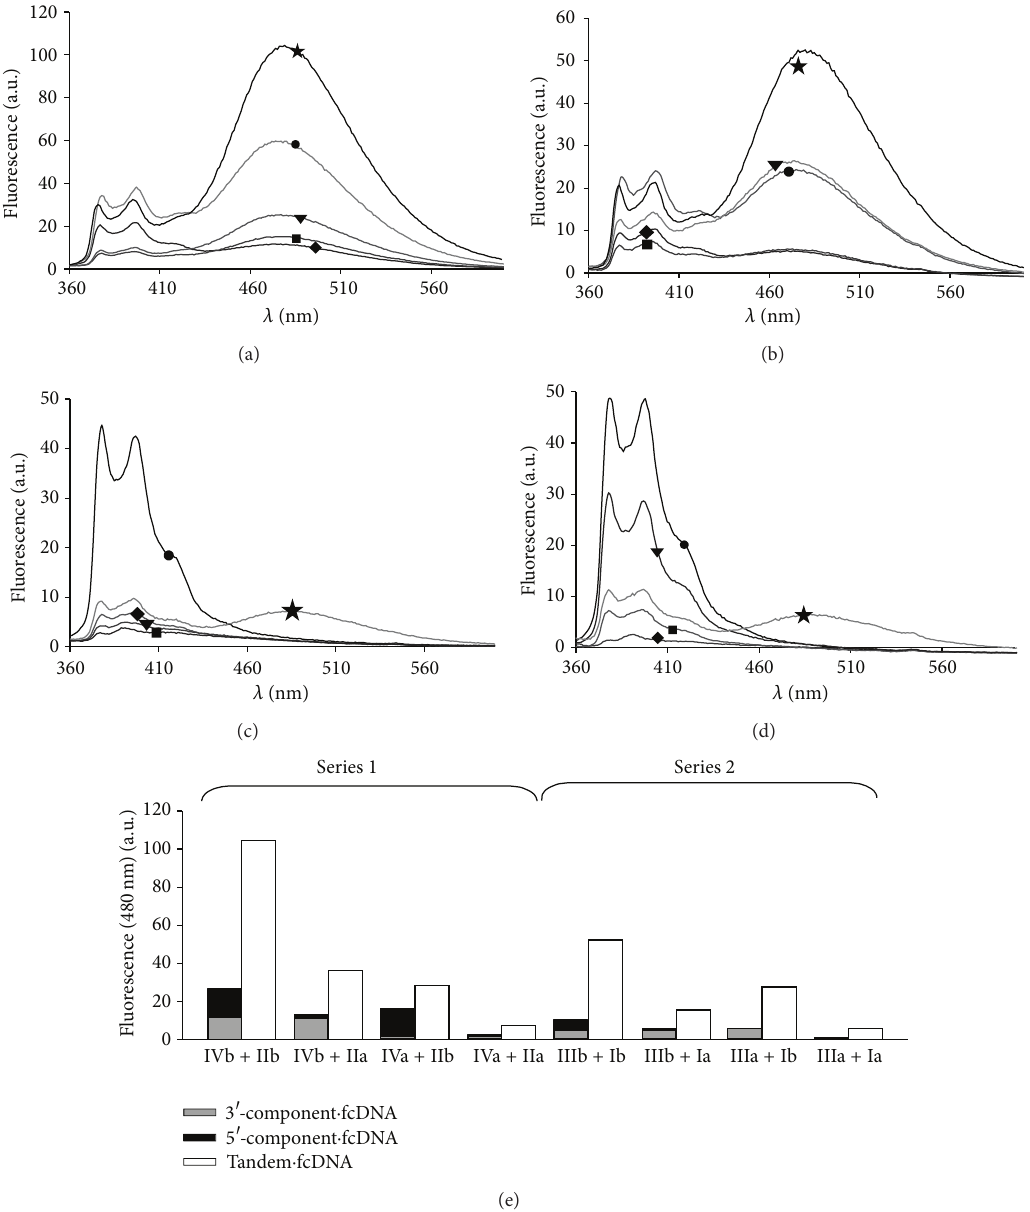
Figure 3: ((a)–(d)) Fluorescent spectra of individual tandem components ( e = 3 󸀠 -component, 󳶃 = 5 󸀠 -component), their duplexes with fcDNA ( X = 3 󸀠 -component ⋅ fcDNA, ◼ = 5 󸀠 -component ⋅ fcDNA), and duplexes between tandems and fcDNA ( 󳀅 ) for the following tandems: IVb+IIb (a), IIIb+Ib (b), IVa+IIa (c), IIIa+Ia (d). (e) Fluorescence intensity values at 480 nm for duplexes of individual tandem components (gray and black) with fcDNA in comparison with that of tandem duplexes with fcDNA (white). Conditions: 6.7 mM Tris-HCl (pH 8.9), 16mM = 345 nm, [conjugate] = [fcDNA] = 2 ⋅ 10 −7 M, 𝑇 = 25 ∘ (NH 4 ) 2 SO 4 , 3.6 mM MgCl 2 , 𝜆 ex